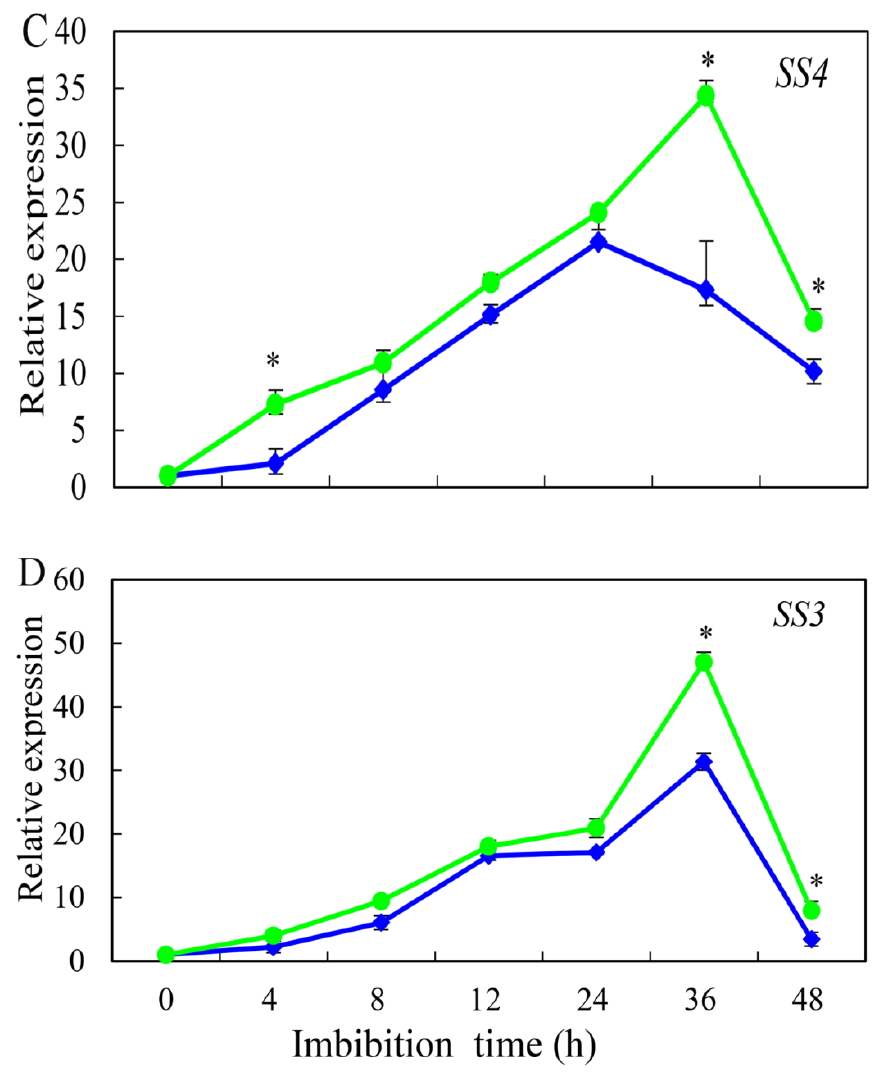
Figure 5. Expression of AMY ( A ), BMY ( B ), SS4 ( C ), and SS3 ( D ) genes in cucumber seed at 0, 4, 8, 12, 24, 36, and 48 h after exposure to different treatments. Treatments consisted of control (distilled water) and 75% HRW treatment. Data are mean ± SE of three independent experiments. The asterisks denote Turkey–Kramer’s t -test significance under different treatments at the same time: * p < 0.05, h: hours, HRW: hydrogen-rich water. AMY : alpha amylase , BMY : beta amylase , SS4 : sucrose synthase 4 , SS3 : sucrose synthase 3 .